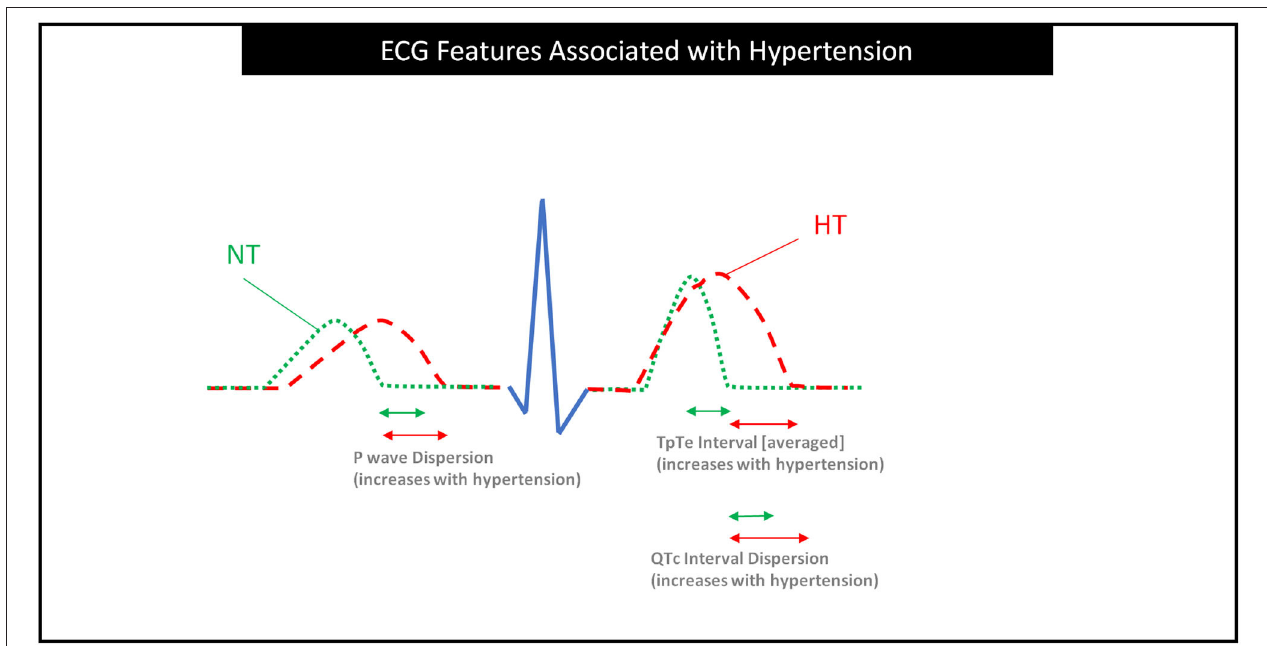
FIGURE 4 | ECG features associated with hypertension based on this study. It is clear that P wave dispersion, TpTe interval, and QTc interval dispersion are increasing in subjects with hypertension. Dispersions are calculated from the difference between the maximum and minimum lengths of the feature. This image shows the normotensive individual as a minimum length and the hypertensive individual as a maximum length to illustrate the longer dispersions in hypertensive individuals. The green arrows are approximated shorter as the normotensive dispersions are significantly shorter from the results of this review. NT, Normotensive; HT,